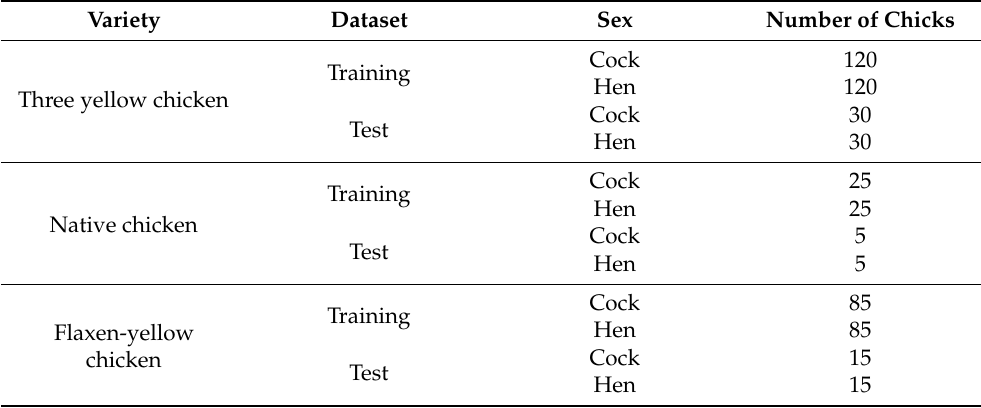
Table 1. The number of chicks in each dataset.